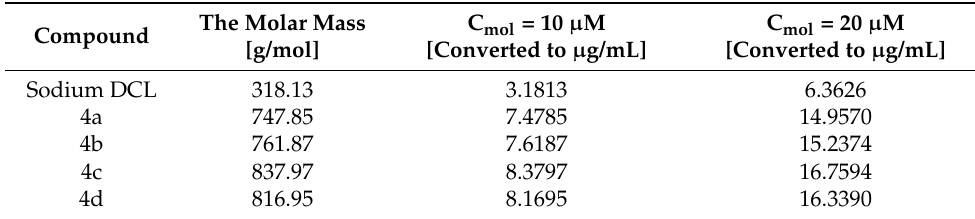
µ g/mL, respectively.